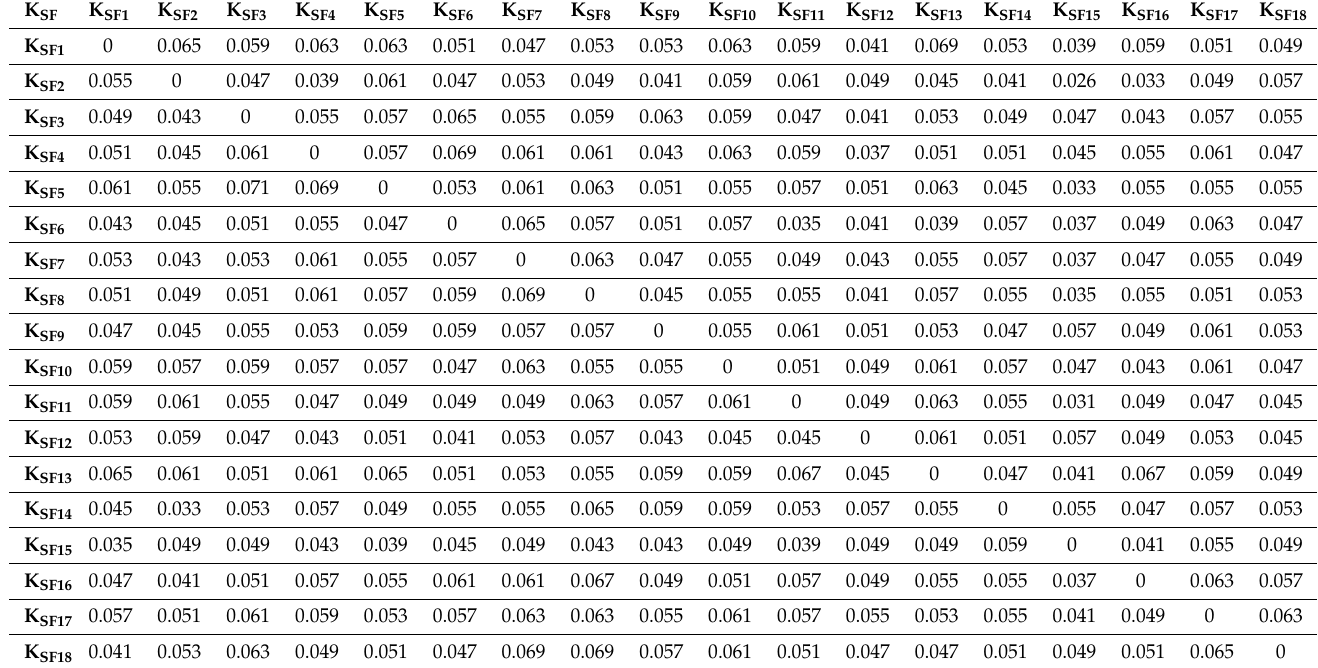
Table A3. Normalized initial direct-relation matrix N.